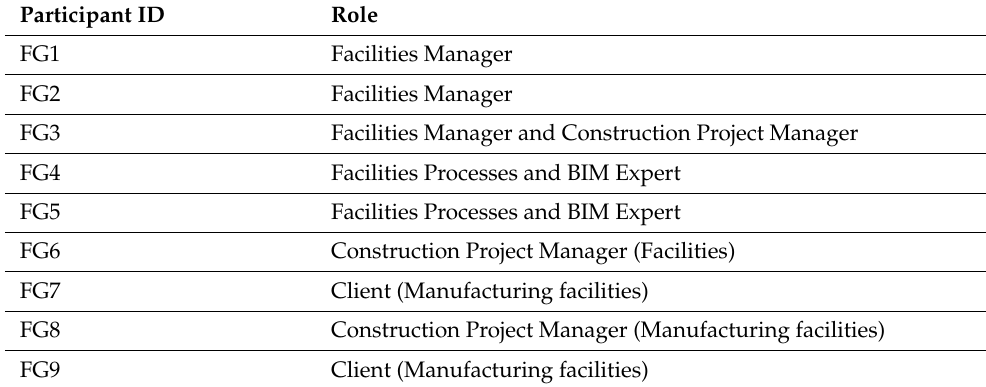
Figure 6. Participants in the Validation Process. Table 2. Participants in the Airbus Focus Group-Ids and